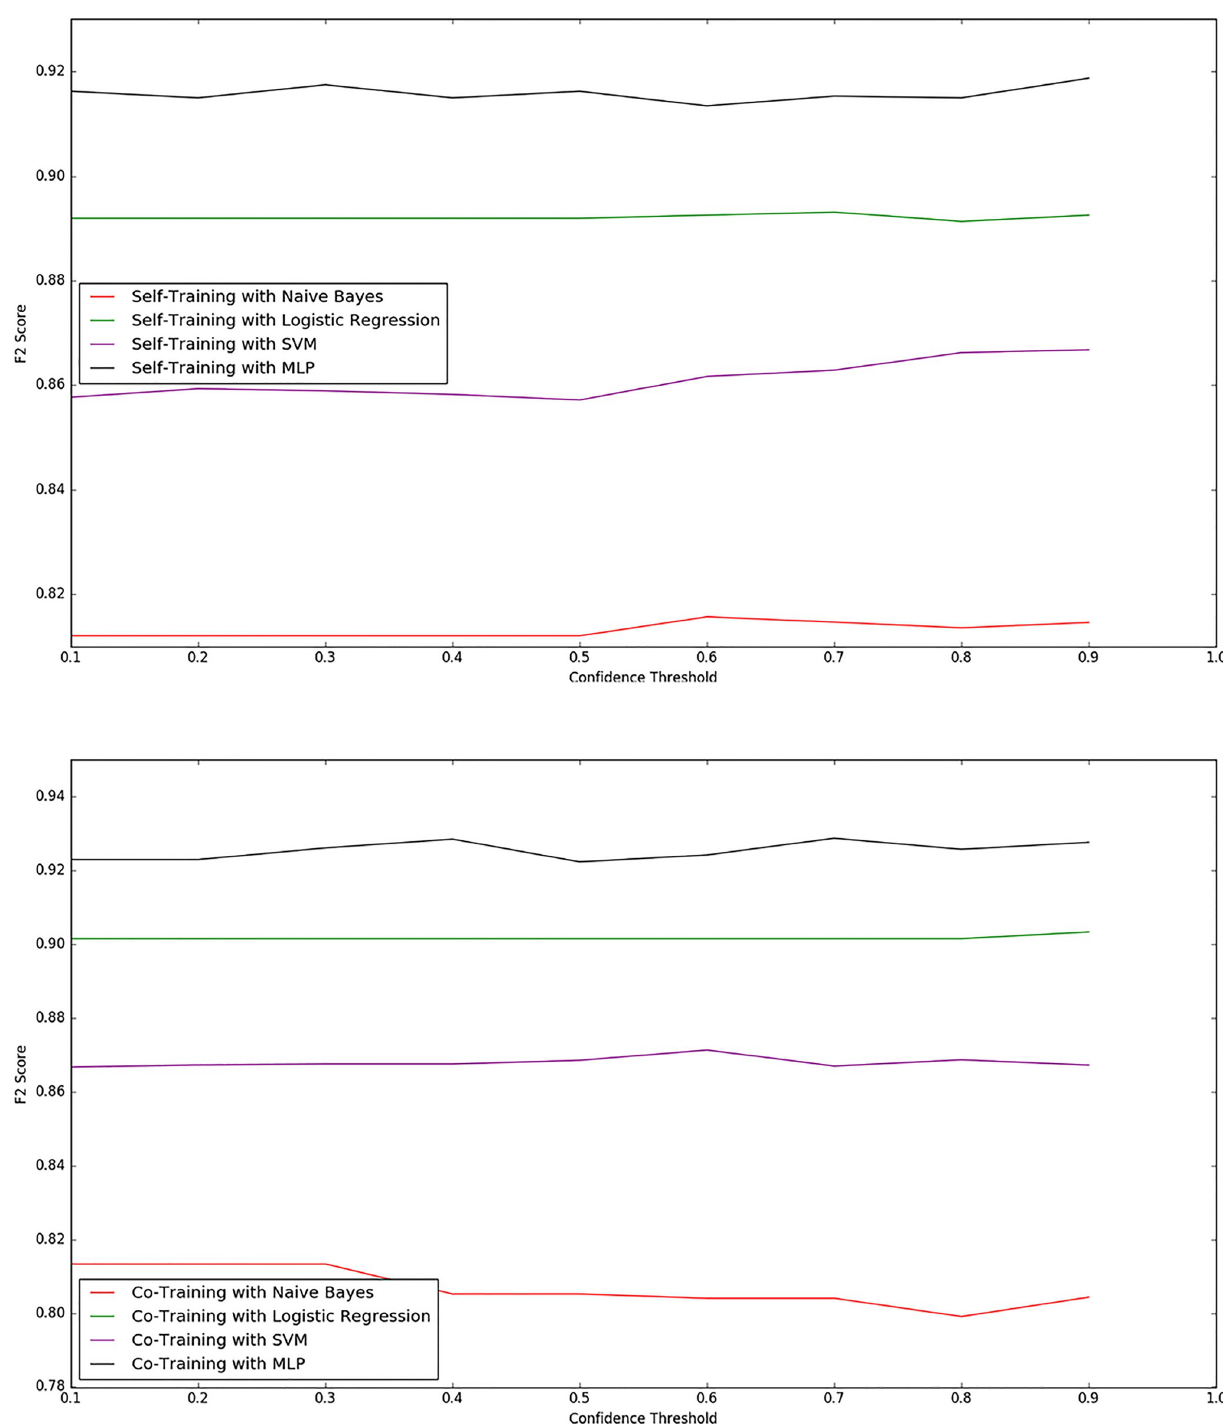
Fig 2. Graph of F2 performance of Iterative Labelling using different confidence thresholds.